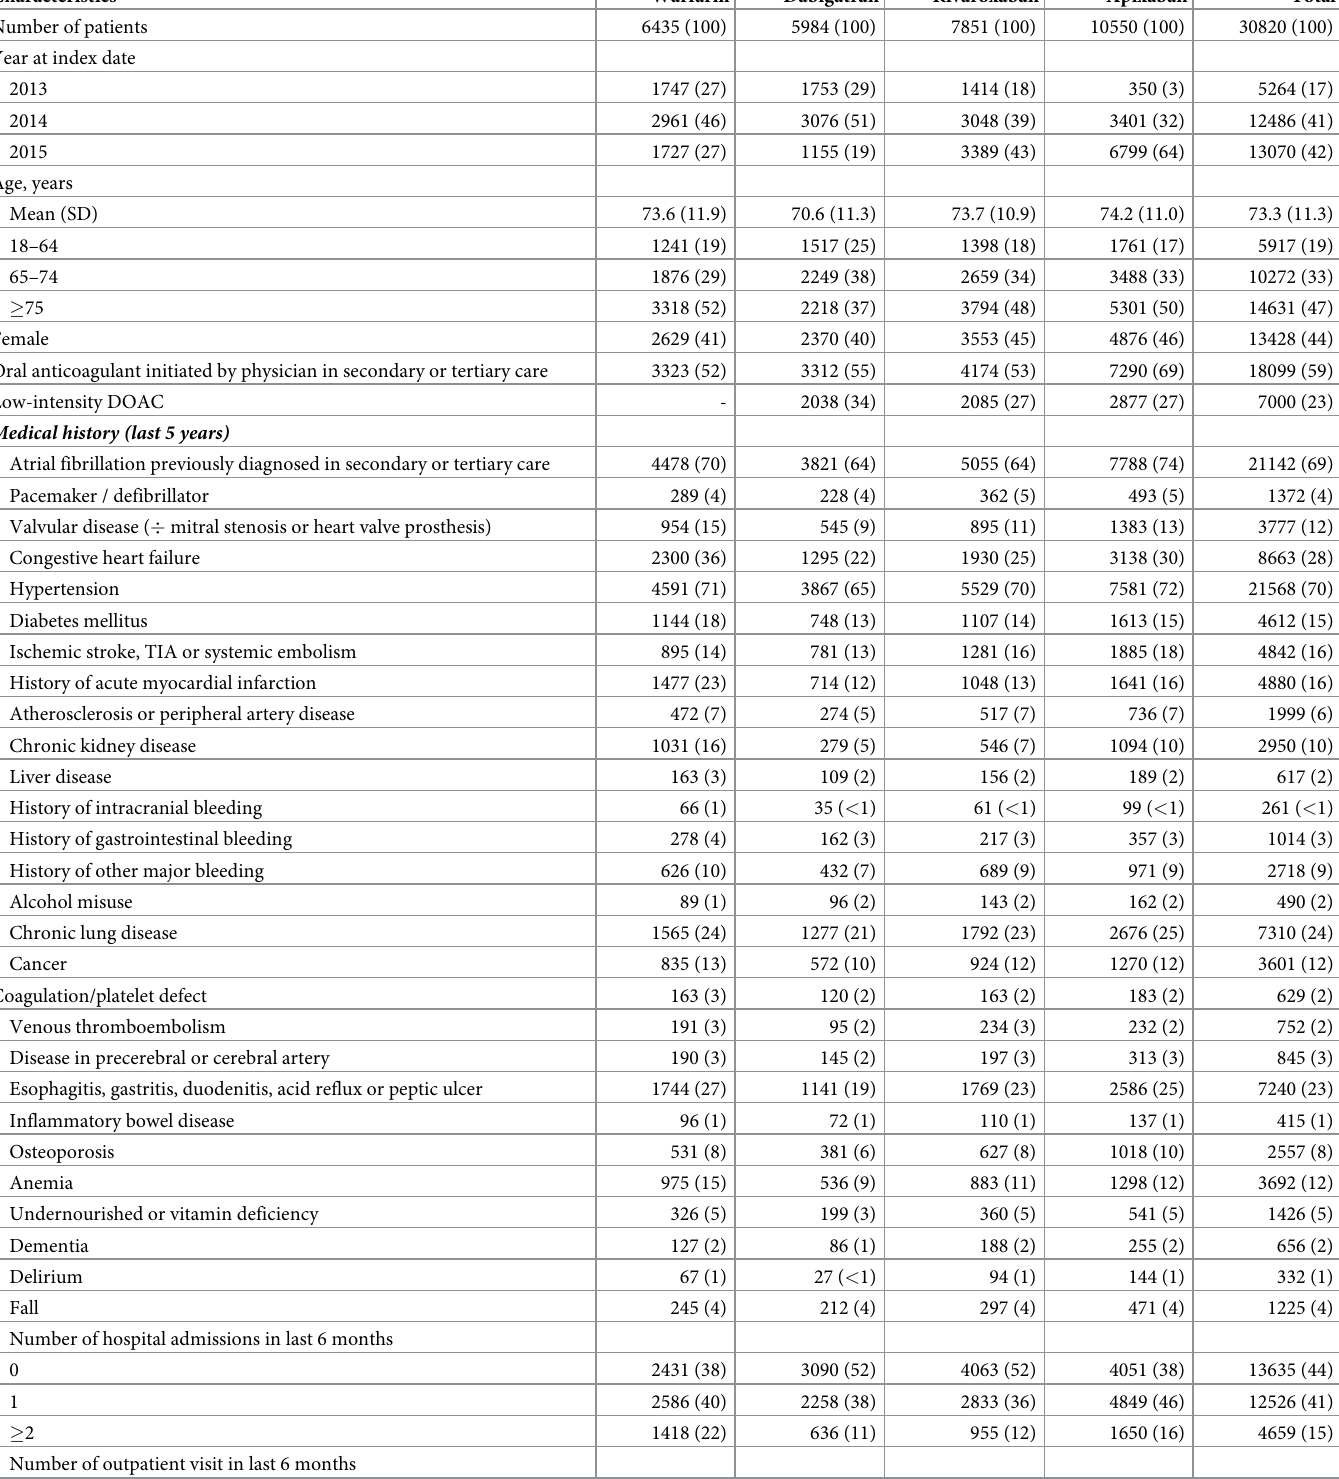
Table 1. Baseline characteristics of non-valvular atrial fibrillation patients initiating warfarin, dabigatran, rivaroxaban or apixaban for non-valvular atrial fibrilla- tion from 15 July 2013 to 31 December 2015 in Norway. Values are numbers (percentages) unless stated otherwise.